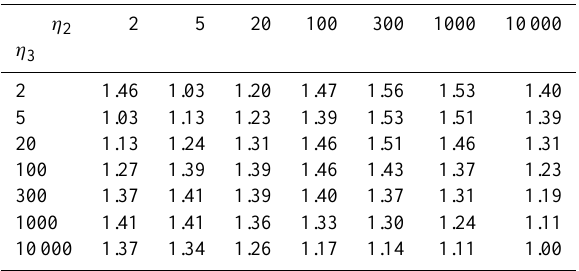
Table A4. Tangent of the slope of the curve showing the depen- dence of the logarithm of L 2 -error for pressure P on the logarithm of the grid step for different viscosity contrasts. Exponentially vary- ing viscosity.